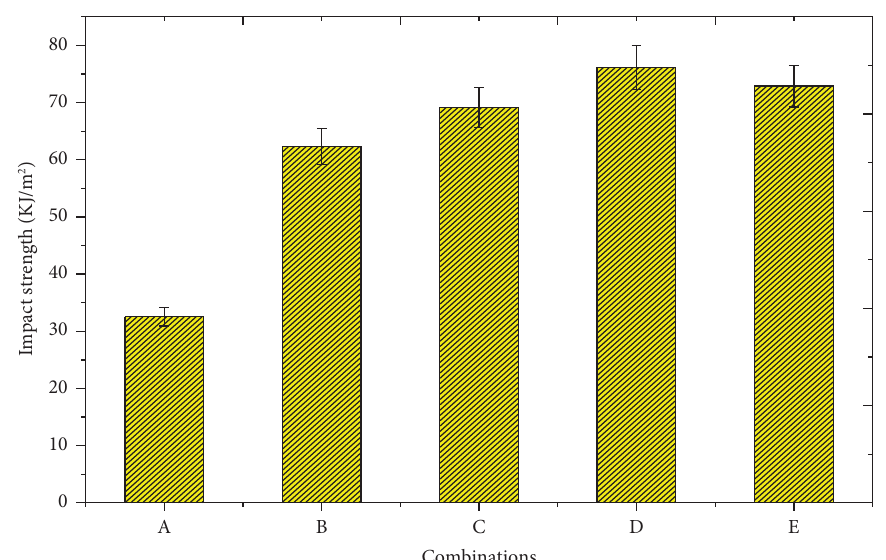
Figure 5: Impact strength of FeO/Kevlar/epoxy based hybrid